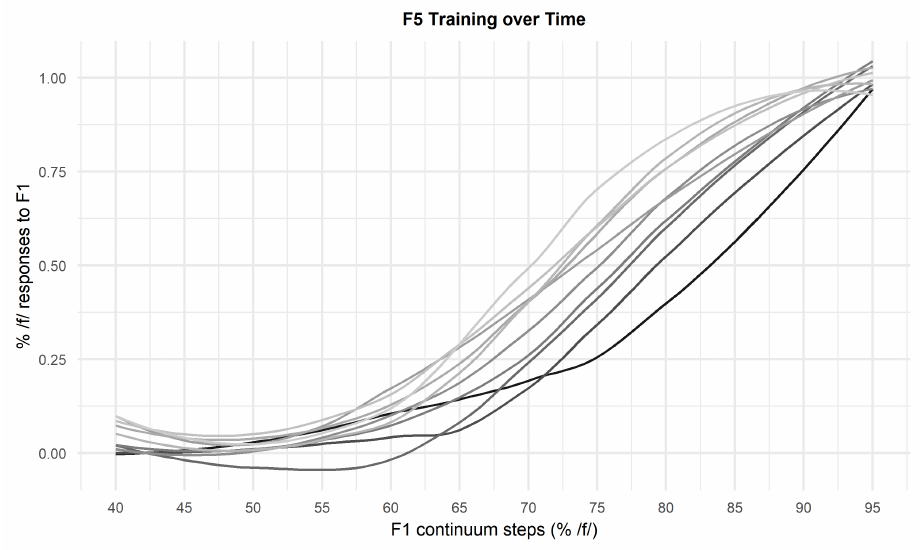
Figure 3: Pre-test classi(cid:976)ication over time (in F5 training condition); lines become lighter over